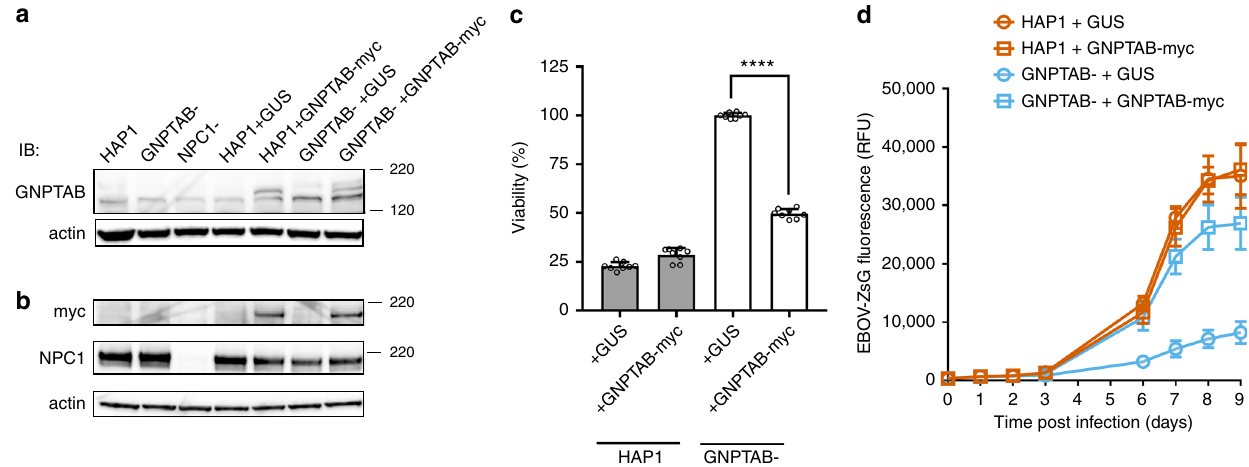
Fig. 3 Reconstitution of GNPTAB in knockout cells restores EBOV infection. Parental HAP1 and GNPTAB − knockout cells were transduced with lentiviruses to express β -glucuronidase (GUS) as a negative control, or myc-tagged GNPTAB (GNPTAB-myc). a , b Immunoblotting of lysates from HAP1, knockout and reconstituted cell lines. The migration of molecular mass markers in kDa is shown on the right. c Reconstitution of GNPTAB restores EBOV-induced cytopathic effect. Cells were infected and viability determined 6 days p.i. as for Fig. 2a. Data represent the mean ± s.d. of eight biological replicates. A representative of two independent experiments is shown. Statistical analysis was performed with a two-tailed Student ’ s t -test with signi fi cance shown as **** P < 0.0001. d Reconstitution of GNPTAB restores EBOV infection. HAP1 and GNPTAB − cells reconstituted to express GUS or GNPTAB-myc were infected with EBOV-ZsG virus and fl uorescence was determined over time. Data represent the mean ± s.d. of six biological replicates. A representative of two independent experiments is patients with MLIII, a less severe form of mucolipidosis, usually characterized by a residual level of GlcNAc-phosphotransferase activity. Cells from 5 MLIII alpha/beta patients with variants in GNPTAB , and from 1 MLIII gamma patient with a variant of GNPTG , were tested (Table 3). The cells from the MLIII patients supported EBOV-ZsG infection to varying degrees (Fig. 4d,